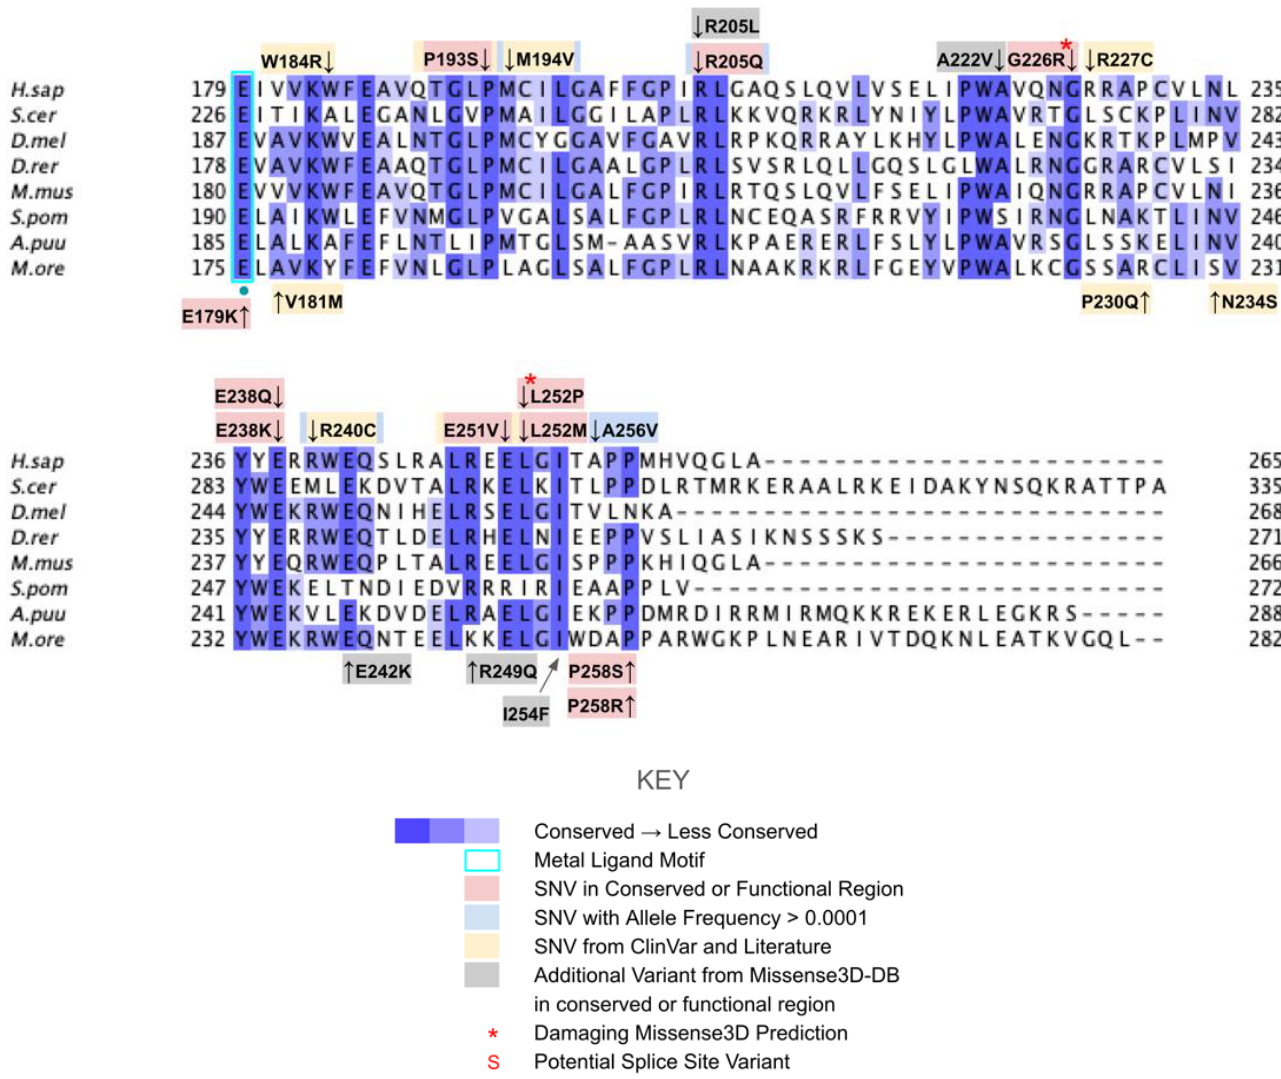
Figure 9. Labeled and annotated multiple sequence alignment of COQ4. Amino acid sequences of COQ4 were analyzed as described in Materials and Methods and include Homo sapiens (NCBI accession number NP_057119.3) and homologs in Saccharomyces cerevisiae (NP_010490.1), Drosophila melanogaster (NP_730270.1), Danio rerio (NP_001108192.1), Mus musculus (NP_848808.1), Schizosac- charomyces pombe (NP_593130.1) , Aspergillus puulaauensis (XP_041555109.1) , and Marasmius oreades (XP_043005754.1). See KEY for descriptions of the figure annotations. The metal ligand motif is boxed in cyan, and putative residues that ligand the metal ions are denoted by a blue dot, data from [47].